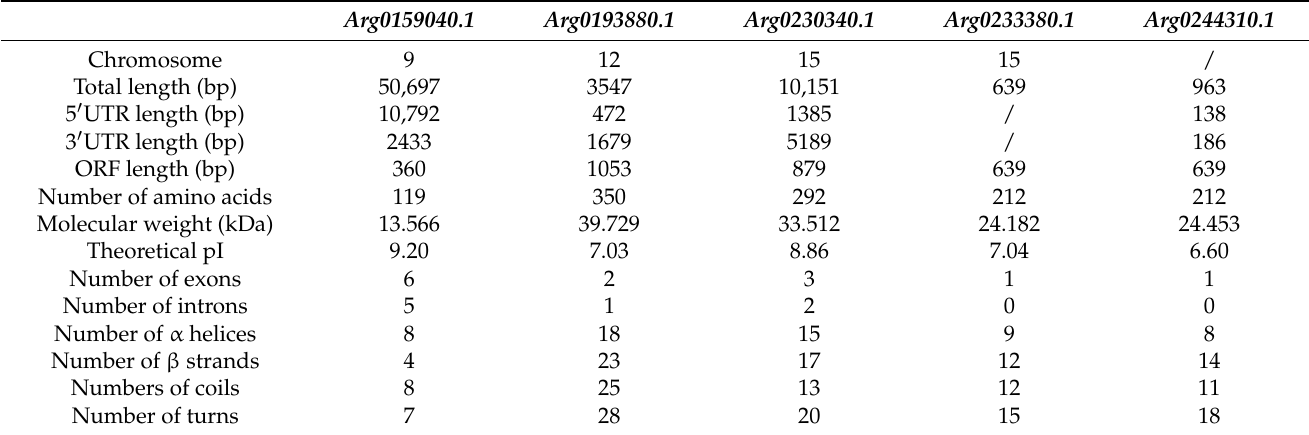
Table 1. Sequence features of AiPC4s from bay scallop A. irradians